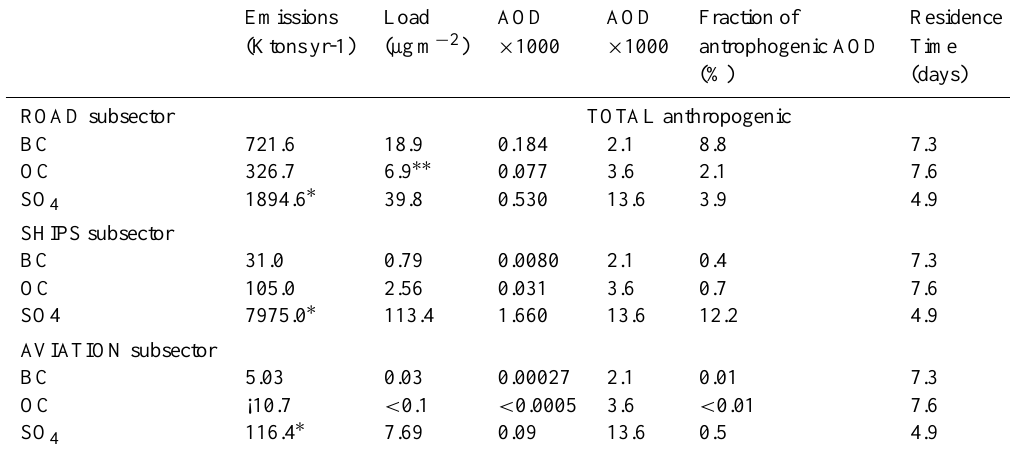
Table 1. Mass emitted, loads and aerosol optical depth (AOD) as computed in the LSCE model for BC, OC and SO 4 emitted by the three sub-sectors.